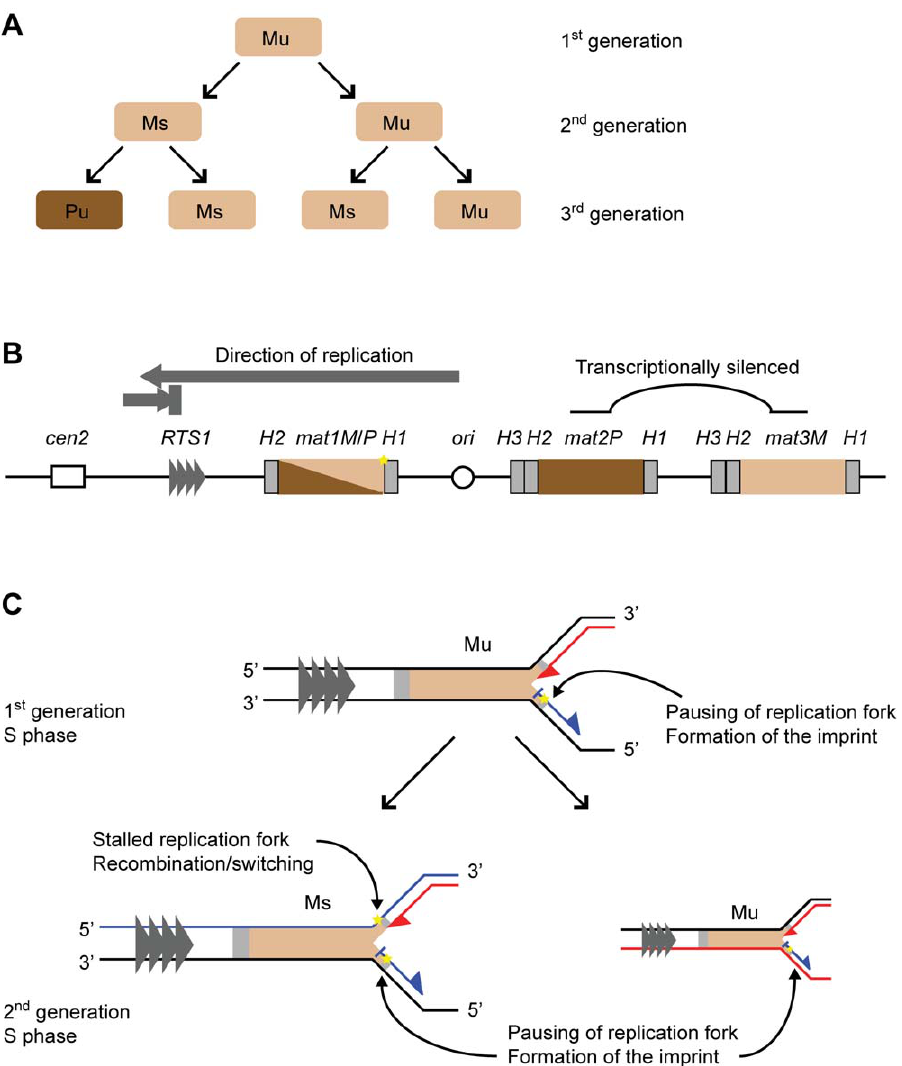
Figure 1. Mating-type switching in S.pombe . (A) Switching pedigree. The cells of minus (M) and plus (P) mating type are represented with light and dark brown colours, respectively. Division of an unswitchable (u) cell leads to the formation of an unswitchable and a switchable (s) cell of the same mating type. Division of the switchable cell gives rise to a switchable cell of the same mating type and an unswitchable cell of the opposite mating type. (B) The mating-type region on chromosome II. The transcriptionally active mat1 locus and the silenced donor loci, mat2P and mat3M , are shown. The M and P information is indicated with light and dark brown colours, respectively. The homology domains H1 , H2 and H3 flanking the loci are represented by grey boxes. The centromere ( cen2 ) and the origin of replication located centromere-distal to mat1 are shown with a hollow box and a circle, respectively. The replication termination element RTS1 is indicated with grey triangles, and direction of fork movement through mat1 is shown above with grey arrows, representing unidirectional replication. The imprint is indicated by a yellow star. (C) The replication of the mat1 locus in unswitchable and switchable cells. The nascent leading and lagging strands are represented by red and blue lines, respectively. In the second generation, the inherited template strands are also shown in red or blue, depending on which strand they were replicated as during the S phase of the parent. The polarities of DNA strands are indicated with 3 9 and 5 9 symbols. The S phases of both cell types involves pausing of the replication fork at mat1 and the introduction of the imprint in the newly synthesized upper strand. In addition, during the S phase of a switchable cell, the imprint on the upper template strand acts as a lesion to block leading-strand synthesis. The stalled leading-strand replication complex induces homologous recombination between mat1 and the donor loci leading to mating-type